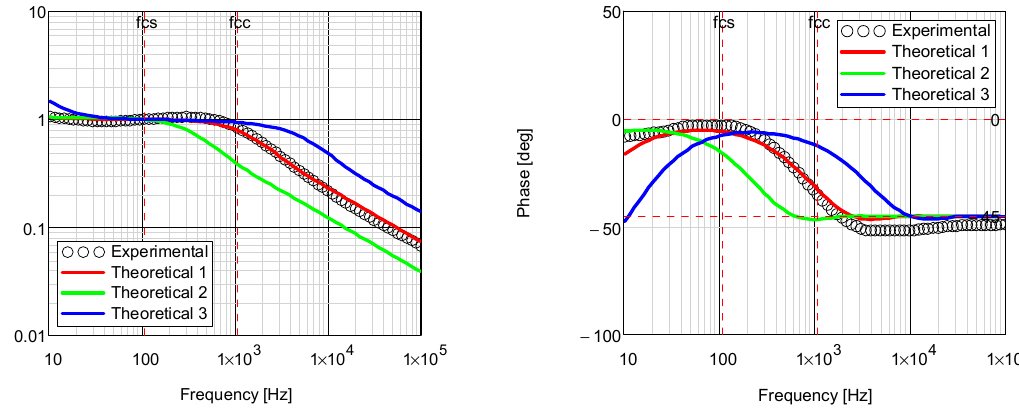
Figure 11. Theoretical and experimental PTR amplitude and phase characteristics obtained for the TMZ-I + Ce(NO 3 ) 3 sample. The solid red line (Theoretical 1) was calculated for the best fit values of thermal parameters ( α c = 2.140 ± 0.078 cm 2 /s, λ c = 2.090 ± 0.250 W/cm · K). The solid green line (Theoretical 2) was calculated for the best fit values of thermal parameters divided by 4 ( α /4, λ /4). The solid blue line (Theoretical 3) was calculated for the best fit values of thermal parameters multiplied by 4 (4 × α , 4 × λ ). Circles are experimental data. The PTR experimental and theoretical amplitude and phase frequency characteristics of the TMZ-II sample are presented in Figure 12.